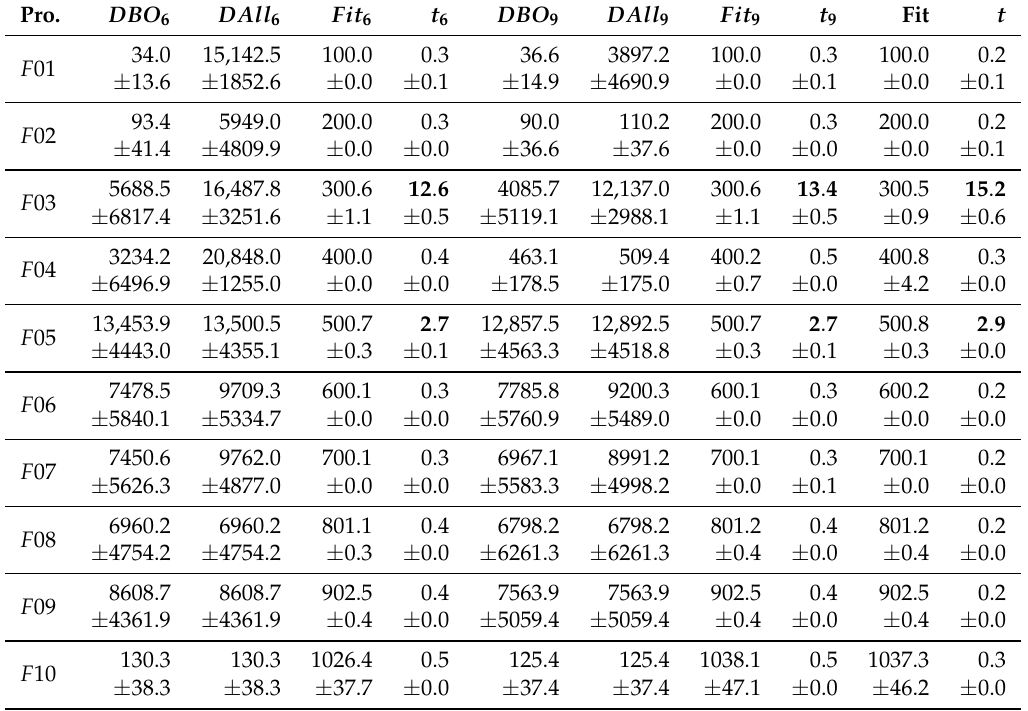
Table 8. jDElscop algorithm on CEC-2015 with LTMA t